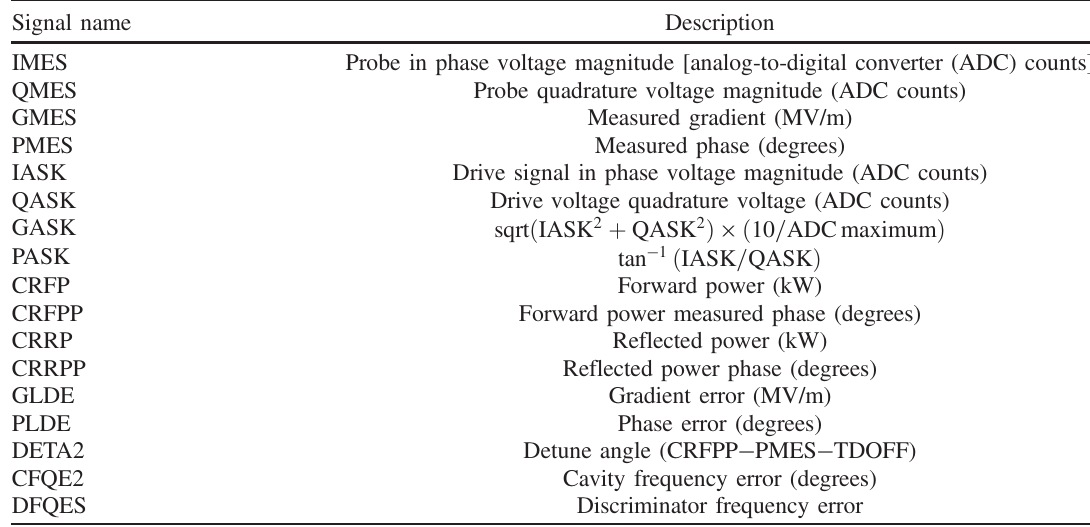
TABLE V. List of the 17 rf signals recorded during a cavity trip along with a brief description of each. Signal name